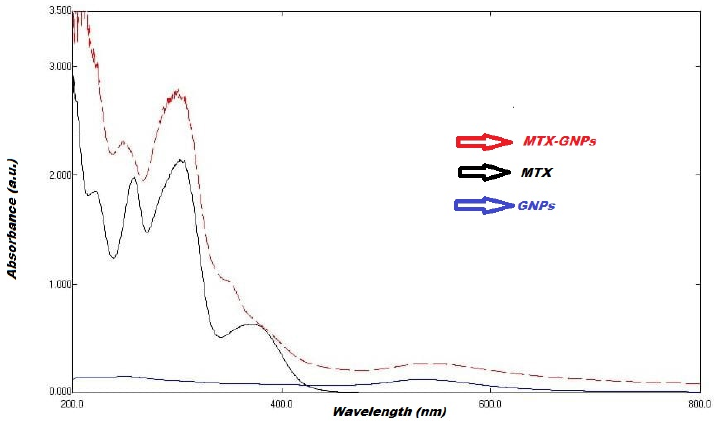
Figure 2. Comparative UV-Vis absorption spectra of free MTX, GNPs, and MTX-GNPs.